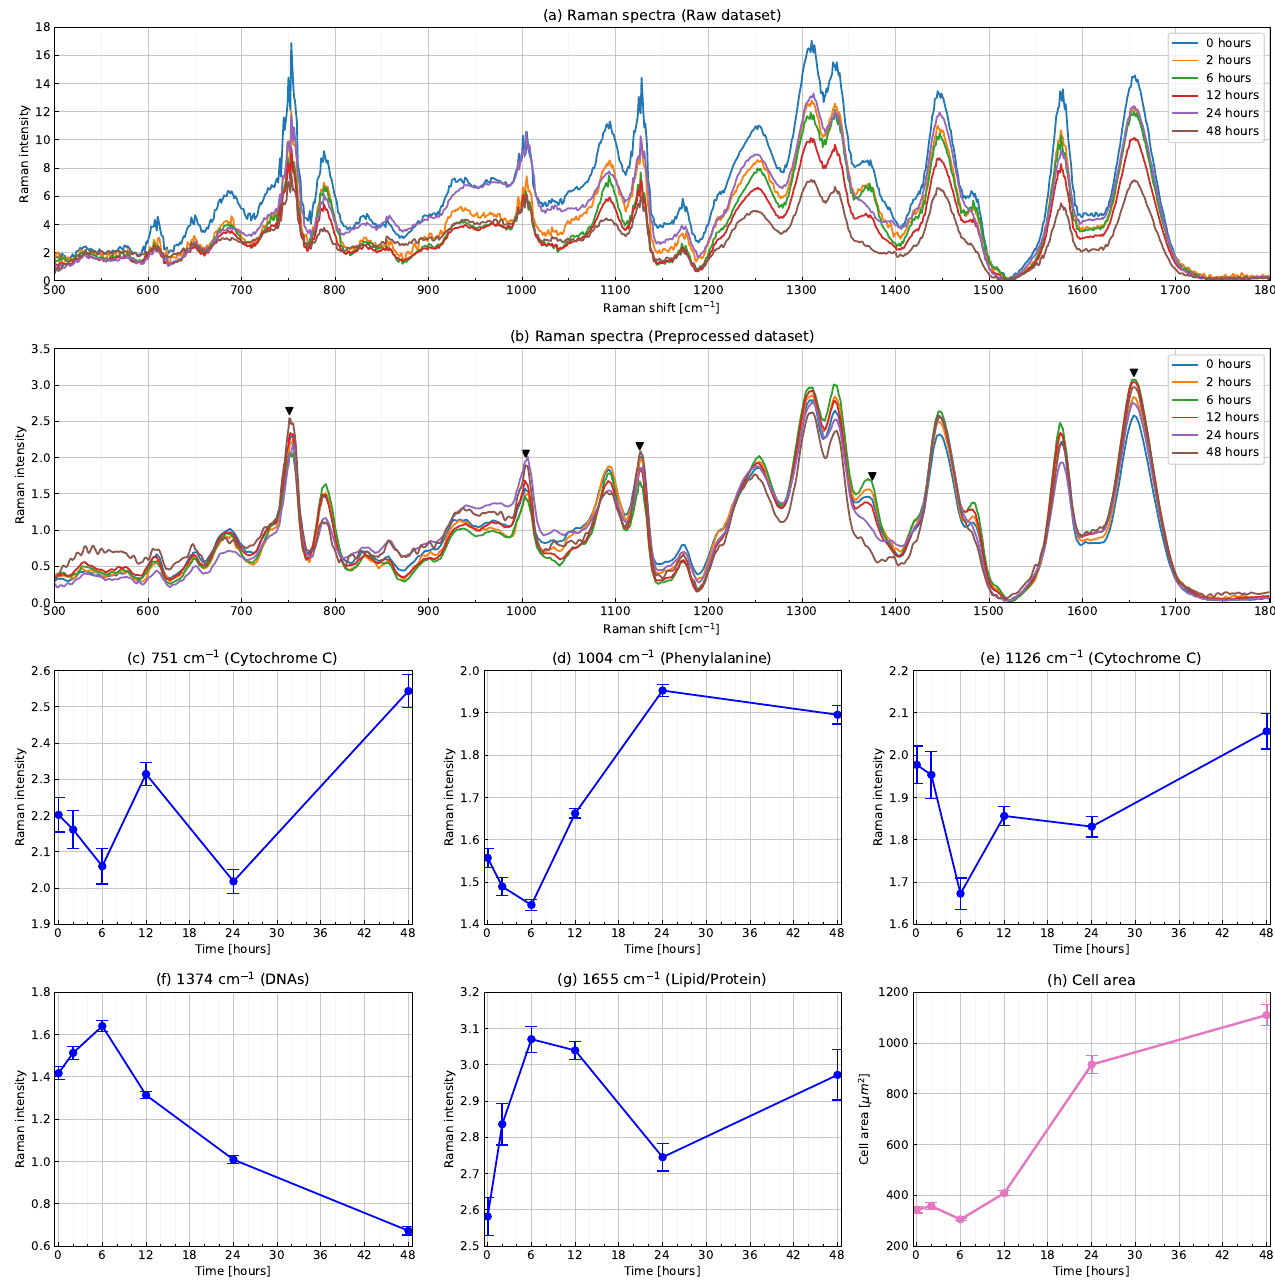
Figure 2. Changes in Raman spectra for the T cell activation process. Raman spectral intensities averaged across cells at each time point produced by ( a ) raw and ( b ) preprocessed datasets. Time evolution of Raman intensities at ( c , e ) cytochrome C, ( d ) the phenylalanine ring breath, ( f ) DNAs and ( g ) lipids/proteins and ( h ) the average cell area. Error bars show the standard deviation in panels ( c – h